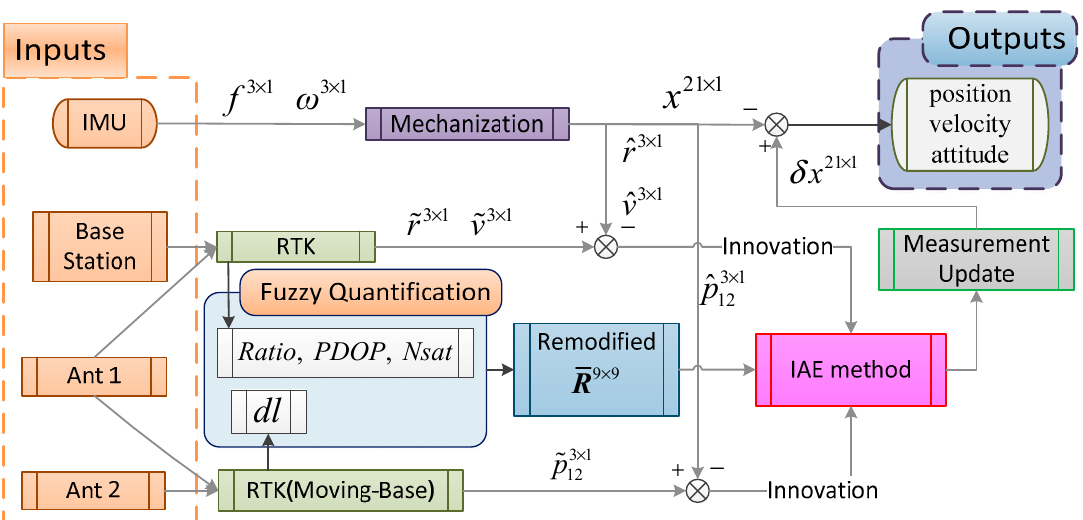
Figure 3. Overall flowchart of the proposed adaptive method in the proposed integration.